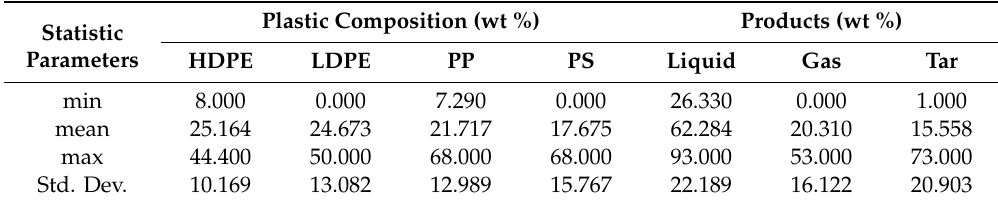
Table 3. The statistical parameters of the input and output data.